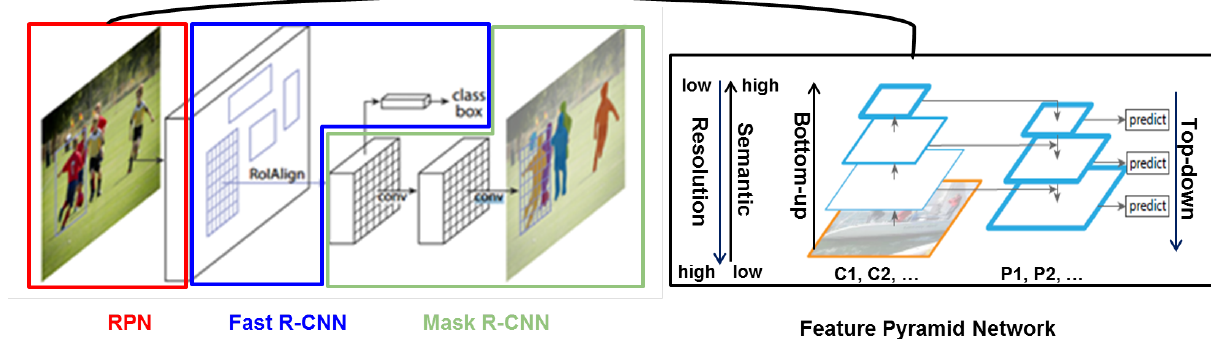
Figure 1. The framework of Mask R-CNN (He et al., 2017, Lin et al., 2017), which combines FPN, RPN and Fast R-CNN.